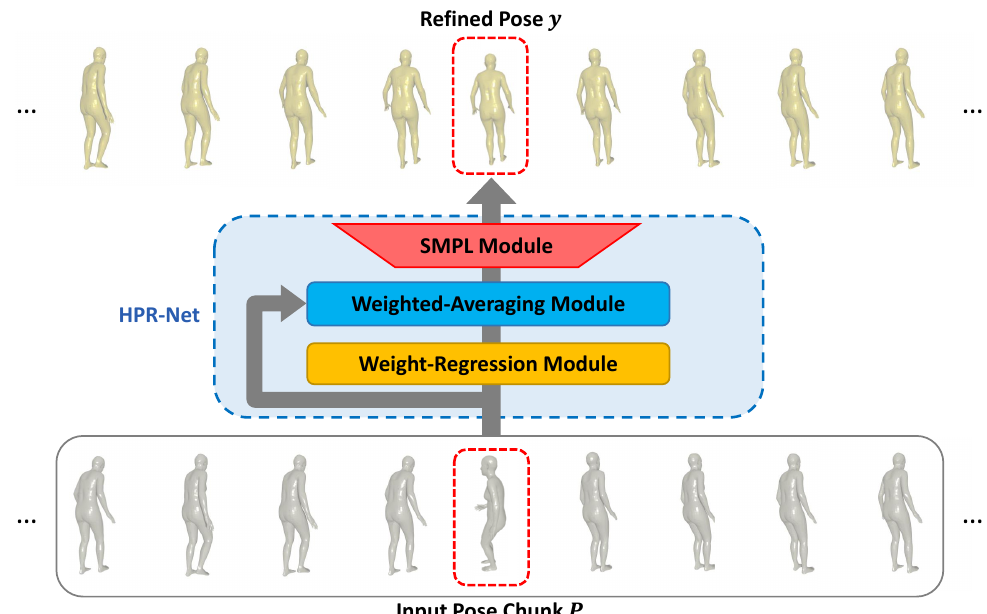
Figure 2. Overall framework of the proposed method. The input to our model is a noisy 3D human pose sequence estimated by existing 3D human pose estimation methods. Our proposed HPR-Net refines the noisy 3D human pose sequence and generates a refined human pose